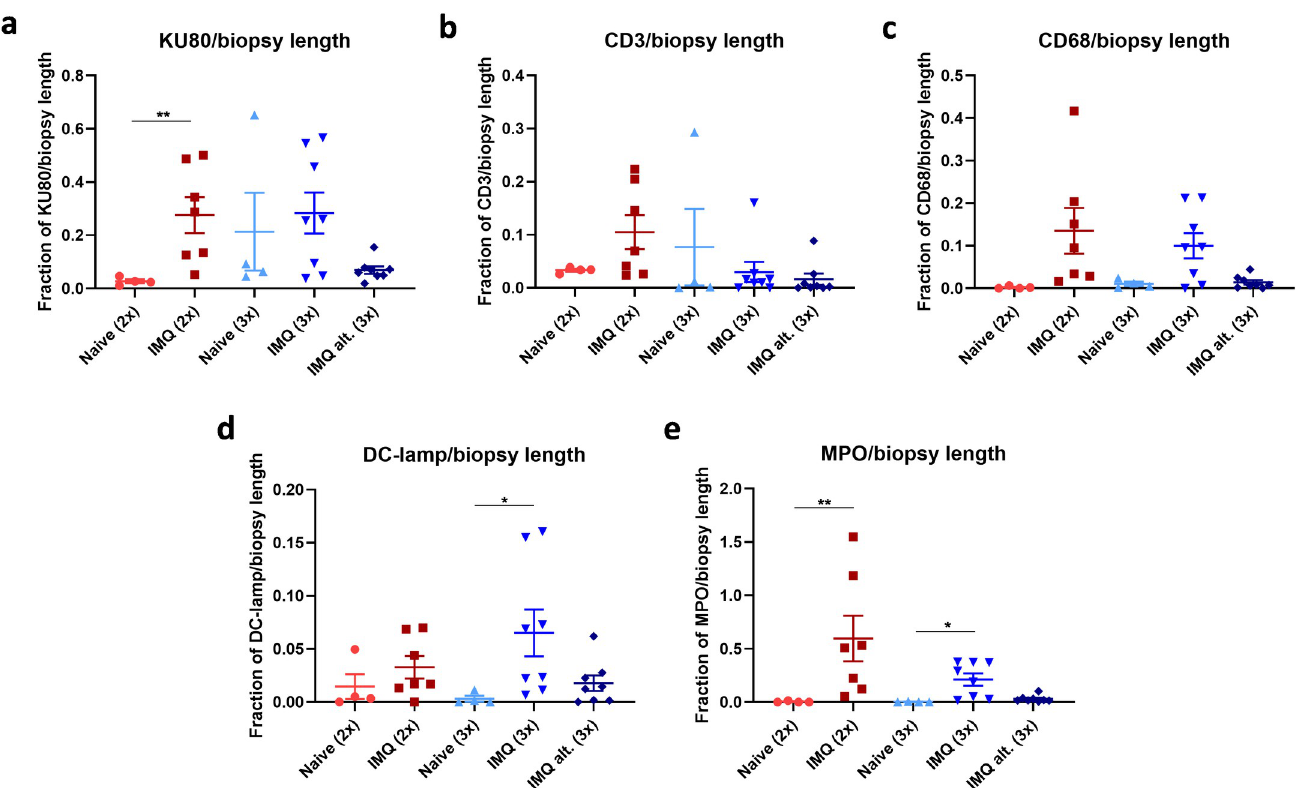
Fig 5. Quantification of human and murine immune cells in the skin. Human and murine leukocytes were identified in the skin by IHC staining. Quantification was performed by measuring the positive staining area of (a) all human cells (KU80), (b) human T-cells (CD3), (c) human monocytes/macrophages (CD68), (d) activated human DCs (DC-lamp) and (e) murine/human neutrophils (MPO) per skin biopsy length with Visiopharm software.